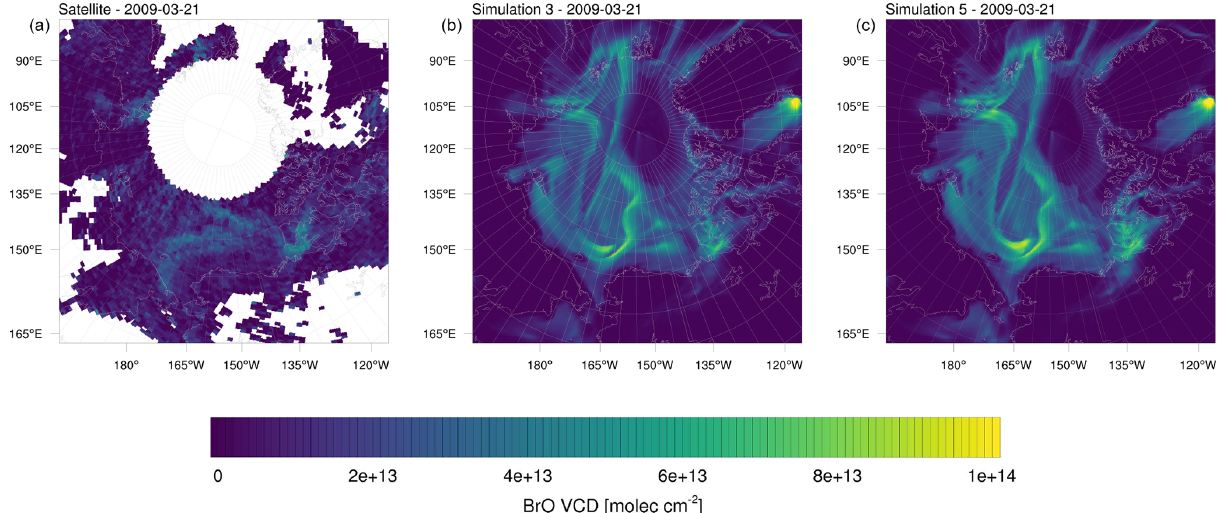
Figure 17. (a) BrO VCDs on 21 March 2009 from observations and simulations initiated on (b) 1 February (simulation 3) and (c) 16 March (simulation 5). The simulations differ only in the start